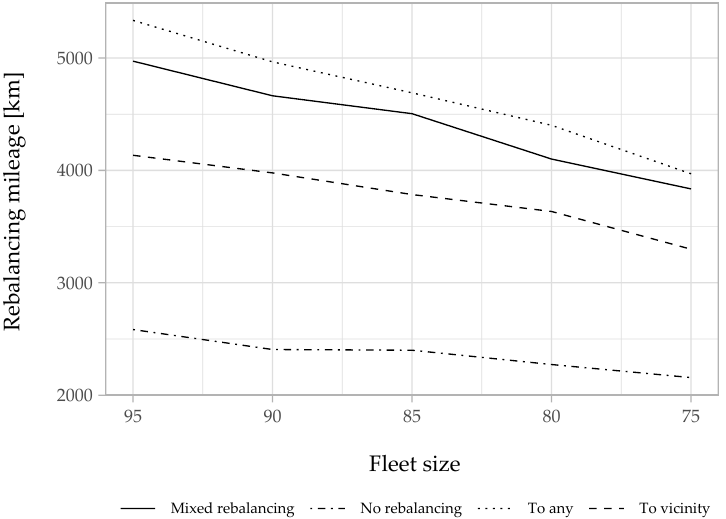
Figure 16. Rebalancing mileage traveled for different fleet sizes (Saturday).